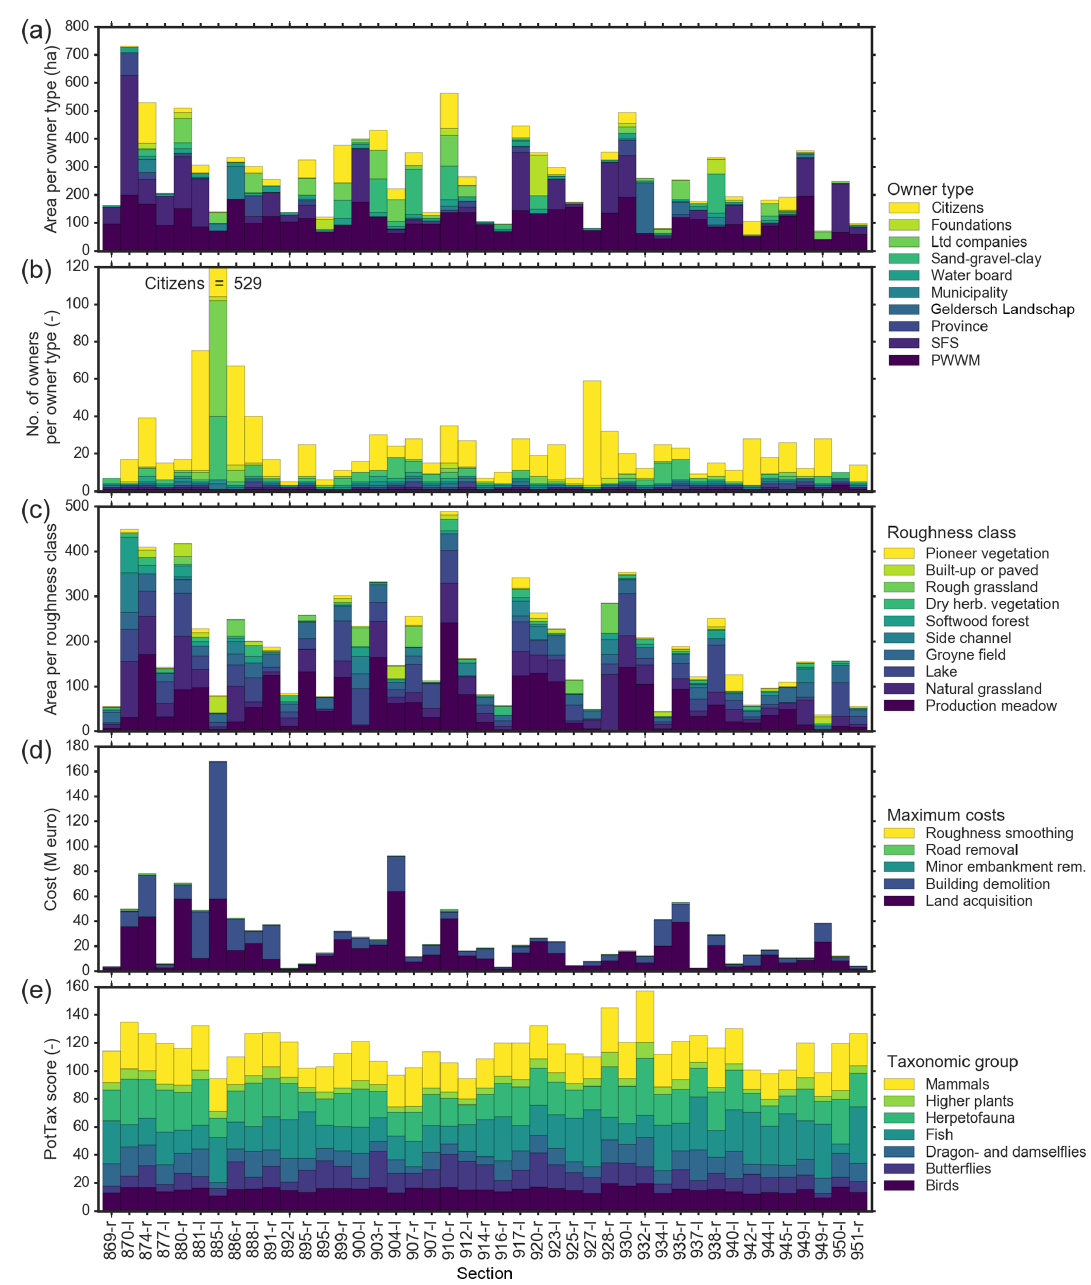
Figure 2. Overview of attributes of floodplain sections (Fig. 1). The sections are labeled by the mean river kilometer, followed by the “- r” for river right and “-l” for river left: (a) surface area per type of owner (churches not shown), (b) number of owners per owner type, (c) surface area of the 10 dominant hydrodynamic roughness classes, (d) costs per item over the whole section in millions of euro (M euro), and (e) floodplain biodiversity scores per taxonomic